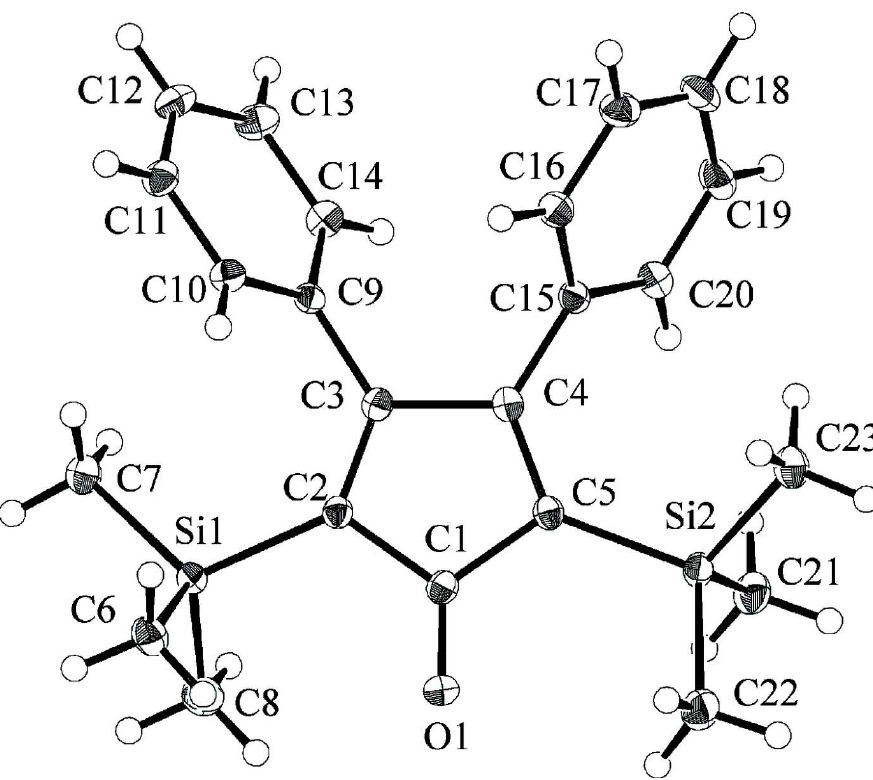
A view of the molecule of (I) showing the atom-labelling scheme. Displacement ellipsoids are drawn at the 40% probability